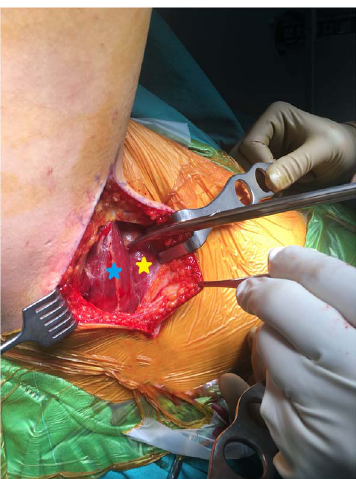
Figure 1. Latissimus dorsi muscle ( yellow asterisk ) and its relationship with teres major ( blue asterisk ). LD muscle is more anterior compared to teres major.